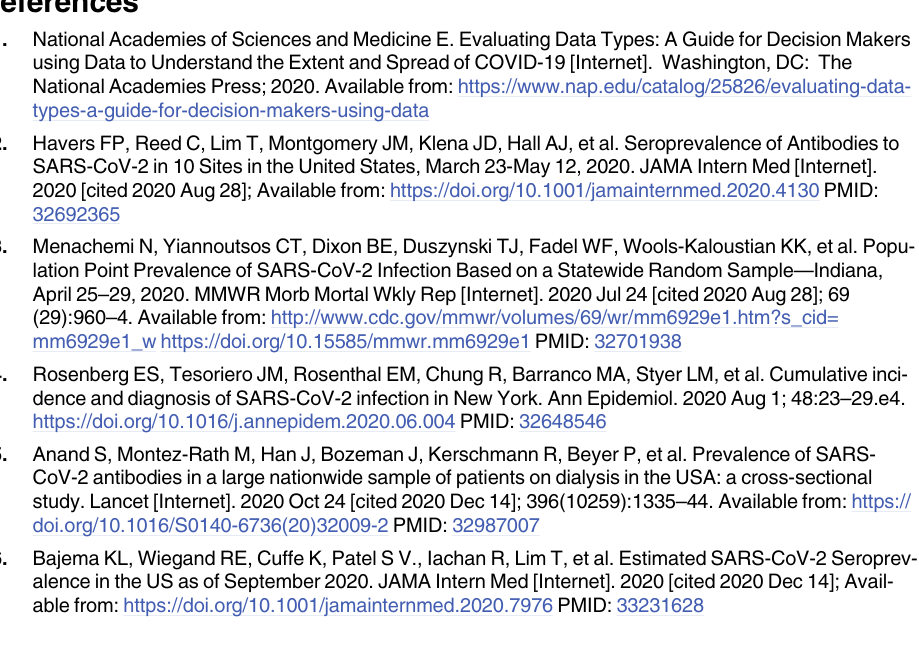
Fig O. Sensitivity of total prevalence predictions to changing averaging time τ from 14 to 7 or 28 days. All predictions are posterior